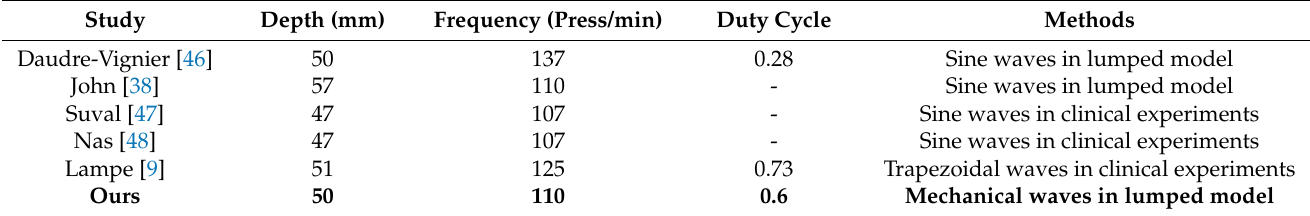
Table 5. Comparison of optimal pressing